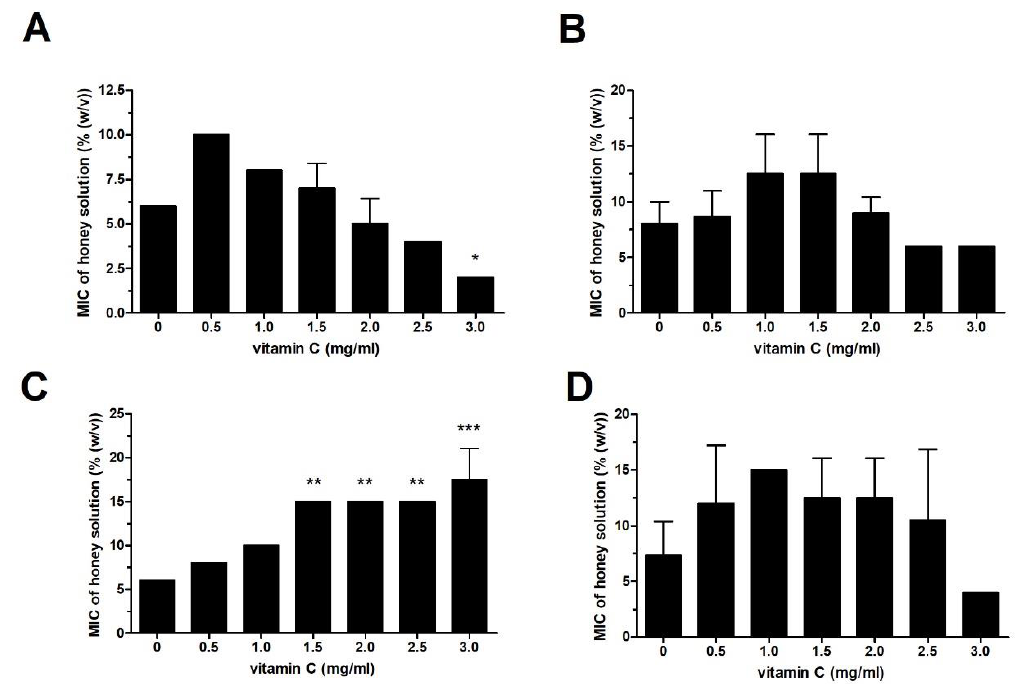
Figure 2. Antibacterial activity of honeydew honey supplemented with Vit C at sub-inhibitory concentrations against bacterial isolates of ( A ) Escherichia coli , ( B ) Serratia marcescens , ( C ) Staphylococcus aureus , and ( D ) Bacillus subtilis . The activity was determined with a MIC assay. The MIC was defined as the lowest concentration of honey solution (%) that inhibited bacterial growth. The data are expressed as mean values with standard deviations. * P < 0.05, ** P < 0.01, and *** P < 0.001.